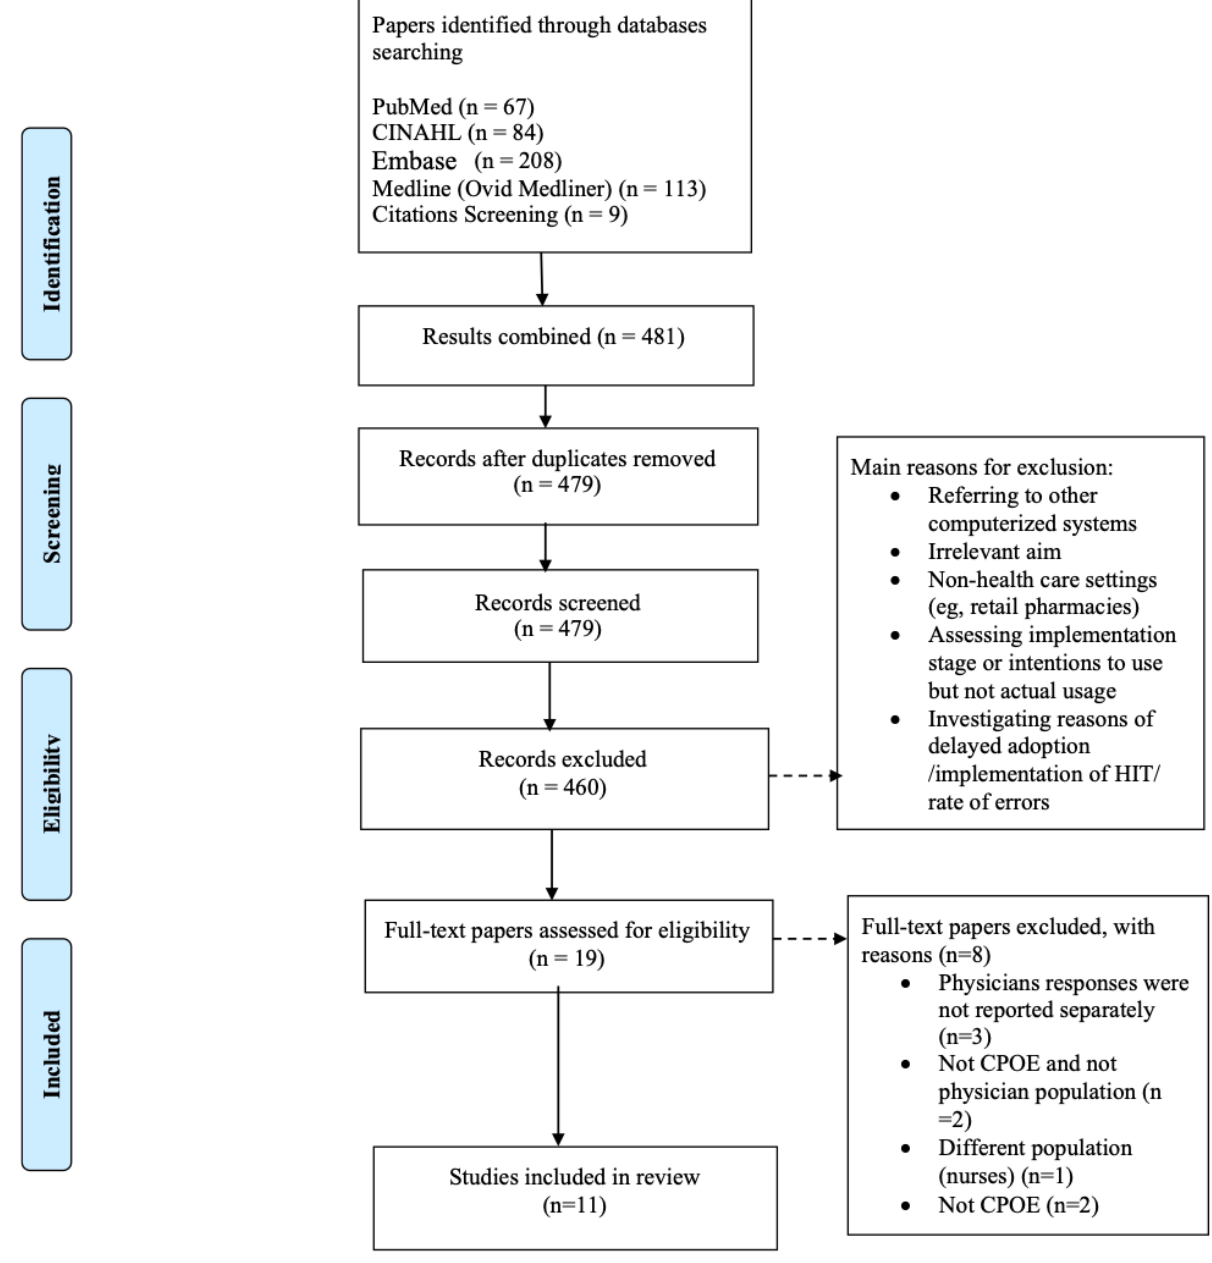
Figure 1. Flow diagram of the selection process for the included papers. CPOE: computerized physician order entry; HIT: health information